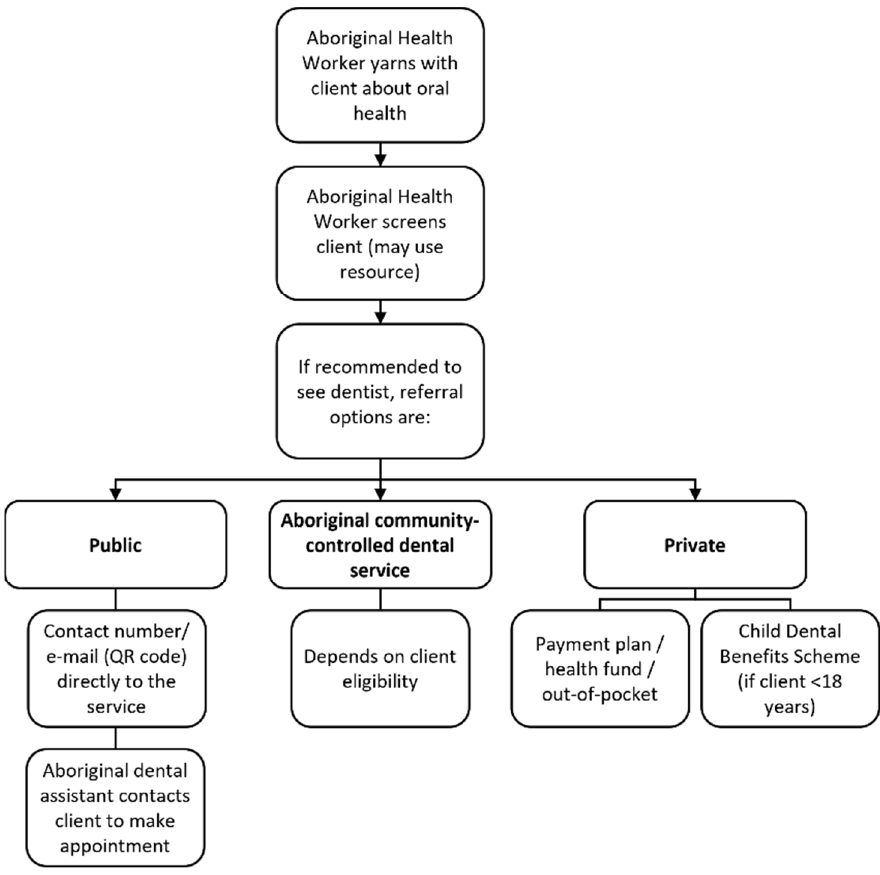
Figure 2. Dental referral pathways for the Grinnin’ Up Mums & Bubs model of care.